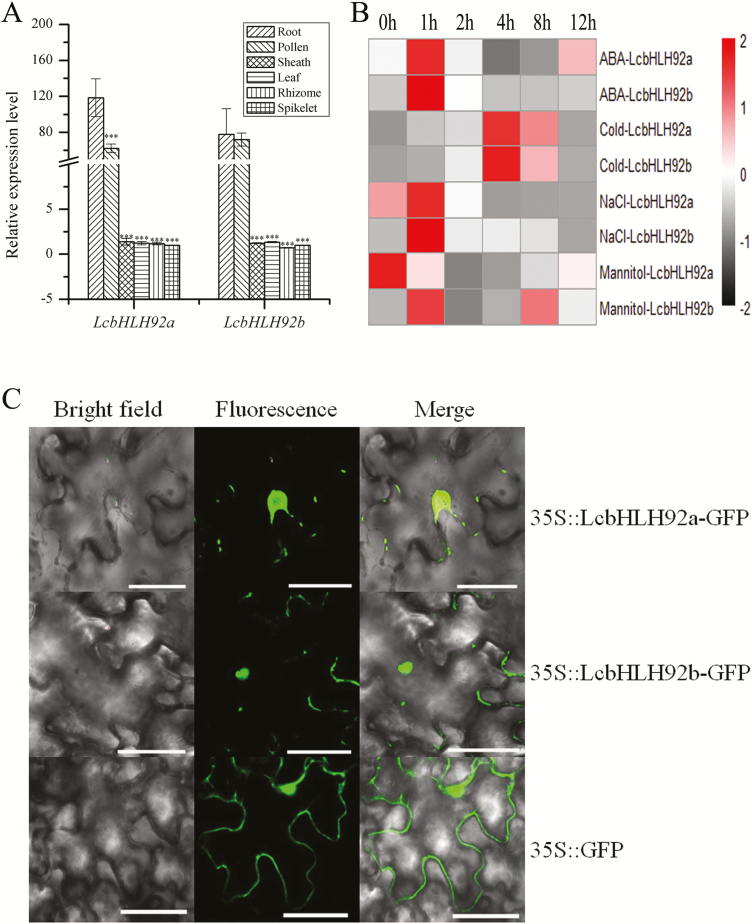
Expression profile and subcellular location of LcbHLH92a and LcbHLH92b. (A) Relative expression levels of LcbHLH92a and LcbHLH92b in roots, pollen, sheaths, leaves, rhizomes, and spikelets by qRT-PCR analysis. Data indicate mean ±SDs of three technical replicates (***P<0.001). (B) Expression profile of LcbHLH92a and LcbHLH92b under ABA, cold, NaCl, and mannitol treatments at 0, 1, 2, 4, 8, and 12 h by qRT-PCR analysis. (C) Subcellular location of LcbHLH92a and LcbHLH92b in tobacco epidermal cells fused with GFP. Scale bar=60 μm.